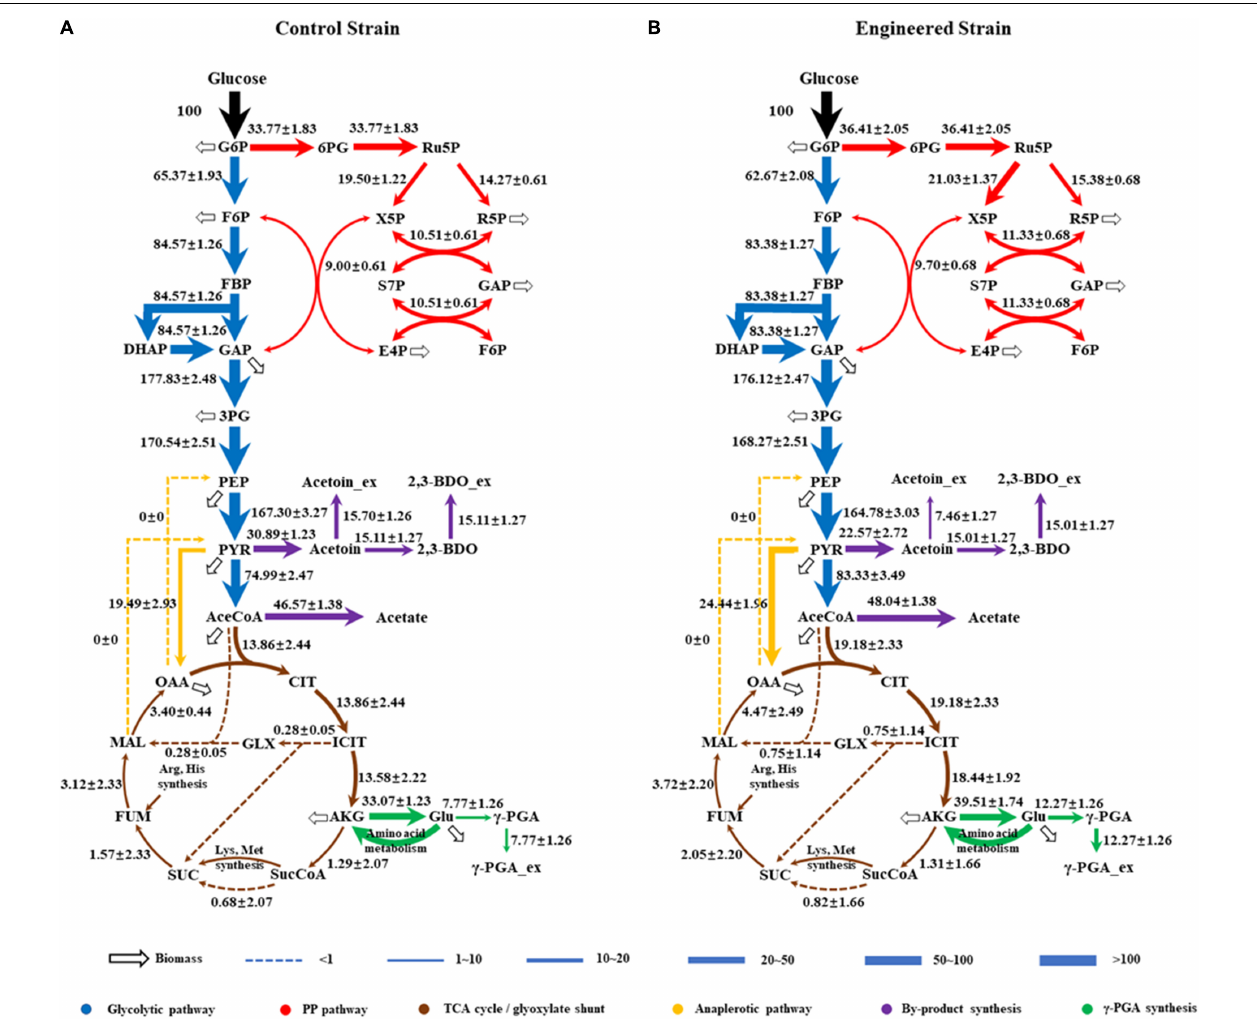
FIGURE 4 | Metabolic flux distributions in the central metabolic pathways of WX-02/pHY300 and WX-02/pHY -dltB during exponential growth on [1,2- 13 C]glucose. Fluxes shown are normalized to glucose uptake rate of 100 for each strain (estimated flux ± SD). (A) WX-02/pHY300. (B) WX-02/pHY- dltB .